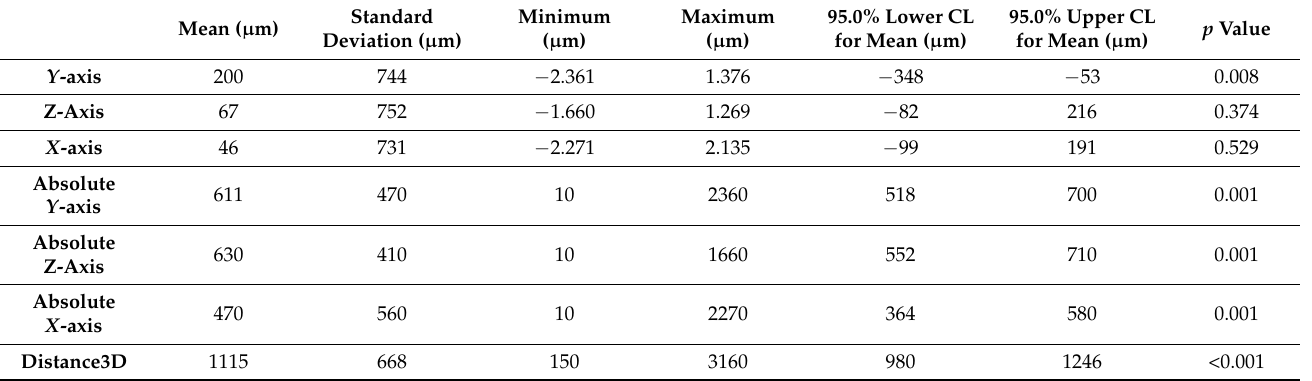
Table 1. Description and p values for all